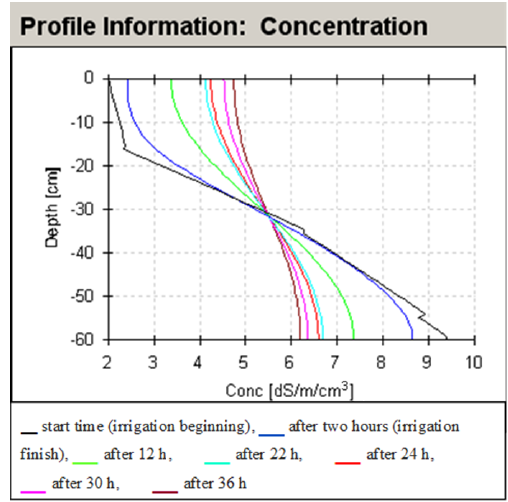
Figure 14. Changes in soil salinity in the soil profile calculated in the model. Calibration results of the model.